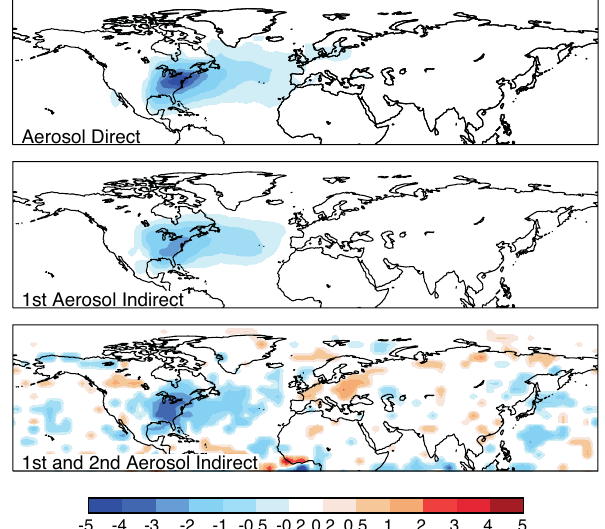
Fig. 7. Annual mean aerosol direct (top), first indirect (middle), and total indirect (bottom) radiative forcing from US anthropogenic sources for year 1980. The aerosol direct effect is calculated assum- ing an internal mixture. Assuming an external mixture would in- crease the radiative forcing over the US by 10%. The direct and first indirect effects are calculated with parallel radiative calculations us- ing perturbed aerosol abundances (direct) and cloud optical prop- erties (first indirect). The total aerosol indirect effect is calculated by difference between 50-year climate equilibrium simulations with and without US anthropogenic aerosols. White areas show no sig- nificant change at the 95th percentile of confidence. The global mean values are − 0.07Wm − 2 for the direct effect, − 0.05Wm − 2 for the first indirect effect, and − 0.08Wm − 2 for the total indirect